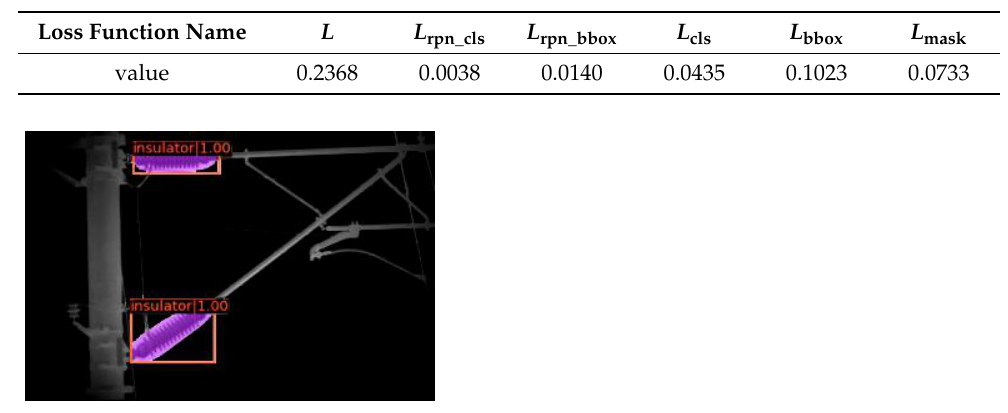
Figure 10. Results of insulator identification.